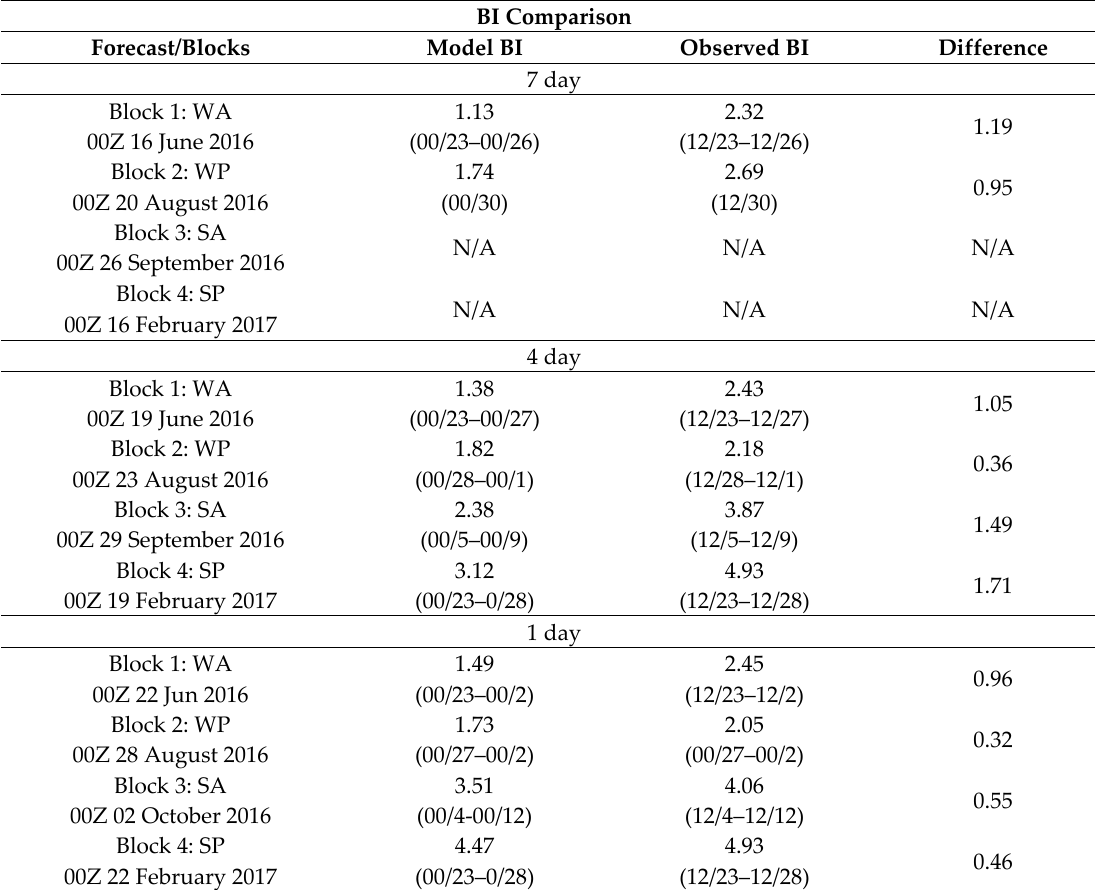
Table 4. The comparison in blocking intensity of the ensemble model forecast vs. observed blocking event during the validation period of all seven-day, four-day and one-day forecast for all four blocking events. N/A: no block present. The difference is OBS—MODEL. Dates of comparison are shown below the BI. BI